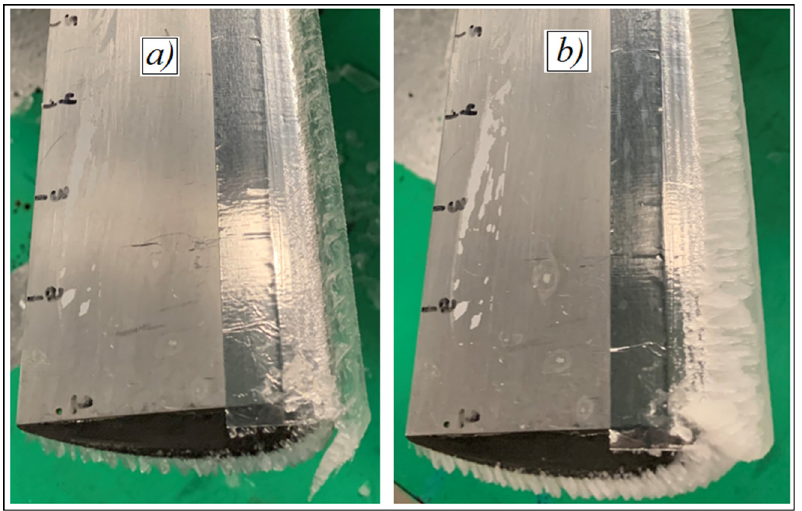
Figure 13. A Comparison between the Ice Types Obtained for Two Different Tests at Ω = 900 RPM and V ∝ = 20 m/s: ( a ) At T ∝ = 265.65 K: Glaze Ice that is Clear and Transparent and ( b ) At T ∝ = 258.15 K: Mixed Glaze/Rime Ice that is White and Opaque yet Slightly Transparent.